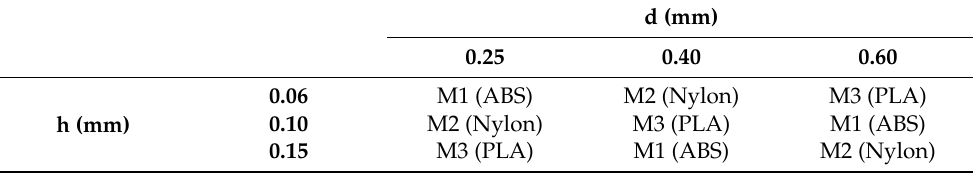
Table 3. The 3 × 3 Latin square design.